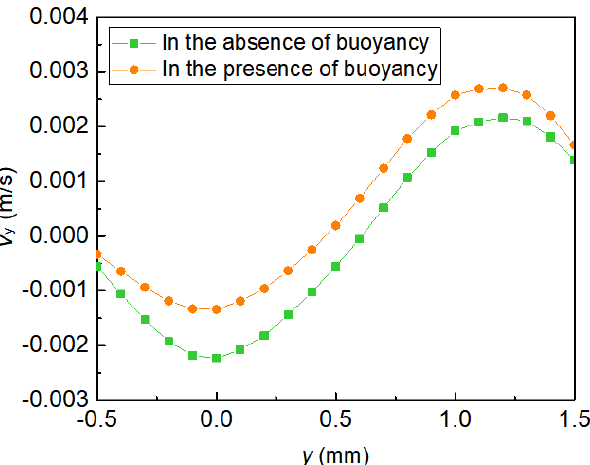
Figure A5. Velocity in the y-direction at the exit: x = 20.6 mm, U 0 = 152 V eff , u 1 = 2.5 mm/s, u 2 = 1.5 mm/s, f = 100 kHz, σ m = 0.001 S/m Velocity profile in the absence of buoyancy (green curve); Velocity profile in the presence of buoyancy (orange